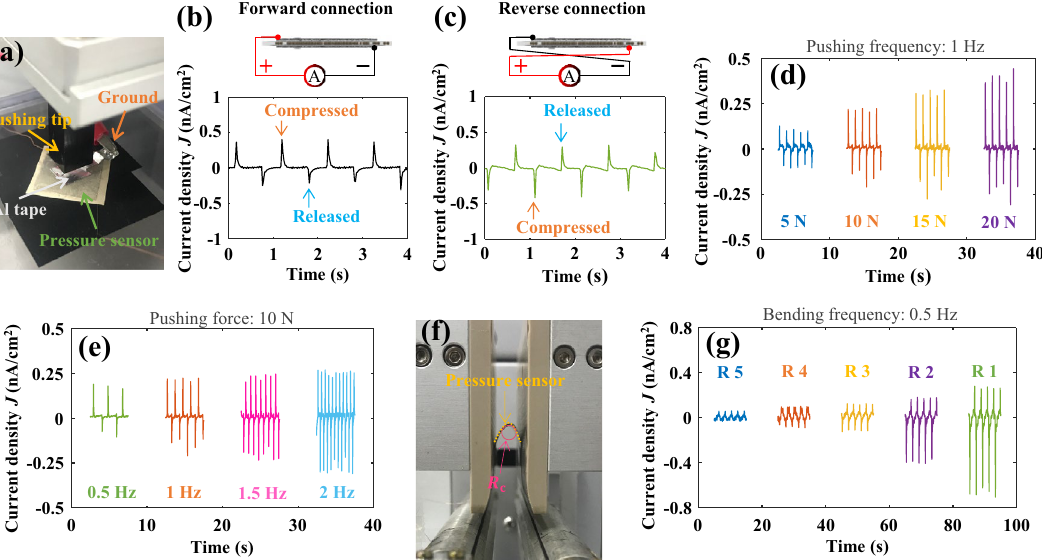
Figure 6. Evaluation of the piezoelectric pressure sensor with the CS NF network electrodes. ( a ) Image of the pressure sensor under the pushing tester (the grounded Al tape is attached to the top surface of the pressure sensor). J of the pressure sensor was measured during the pushing study in the ( b ) forward and ( c ) reverse connection modes. J of the pressure sensor was measured under various pushing ( d ) forces (5–20 N) and ( e ) frequencies (0.5–2 Hz). ( f ) Image of the pressure sensor under the bending tester ( R c indicates the radius of curvature). ( g ) J of the pressure sensor was measured during the bending study with various radii of curvature ( R c = 1–5